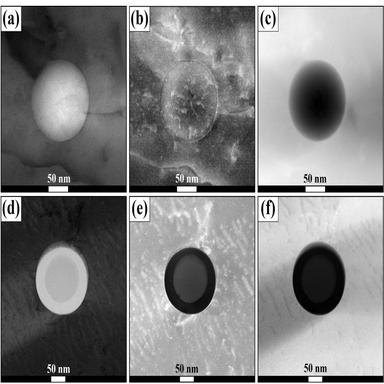
High-magnification HR-STEM microscopy of the dispersed individual (a-c) alumina and (d-f) complex reinforcing nanoparticles through the stainless steel matrix: (a, d) BF, (b, e) DF, and (c, f) HAADF contrast images.